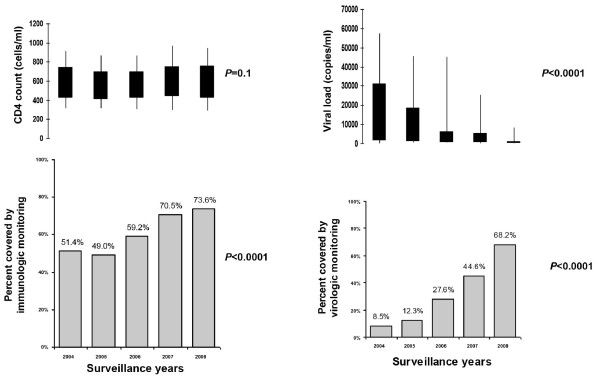
CD4-cell count and viral load testing among HIV-infected women giving birth. CD4-cell counts and percentage covered by immunologic monitoring, viral load and percentage covered by virologic monitoring, HIV-infected women giving birth, St. Petersburg, Russia, 2004-2008, enhanced perinatal HIV surveillance.